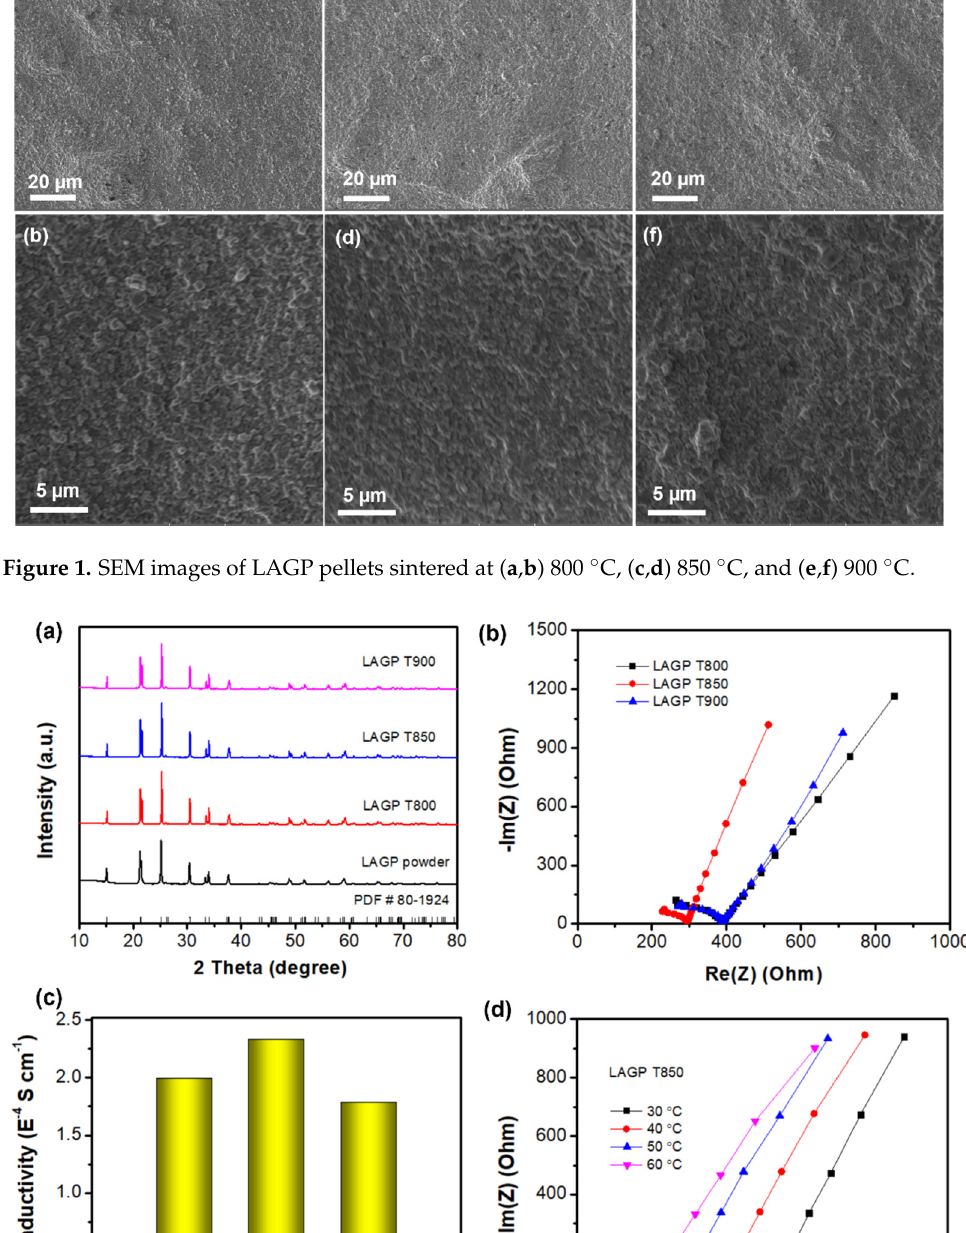
ness of the Al 2 O 3 layer is controlled at 5 nm based on our previous study on the P2- Na 0.66 (Mn 0.54 Co 0.13 Ni 0.13 )O 2 cathode [42]. Figure 3b–g displays the SEM images of LAGP and LAGP@Al 2 O 3 50 from the top view and cross-section. Both demonstrate a compact and flat surface without pores. There is no noticeable change found in the surface and cross-sec- tion morphology.